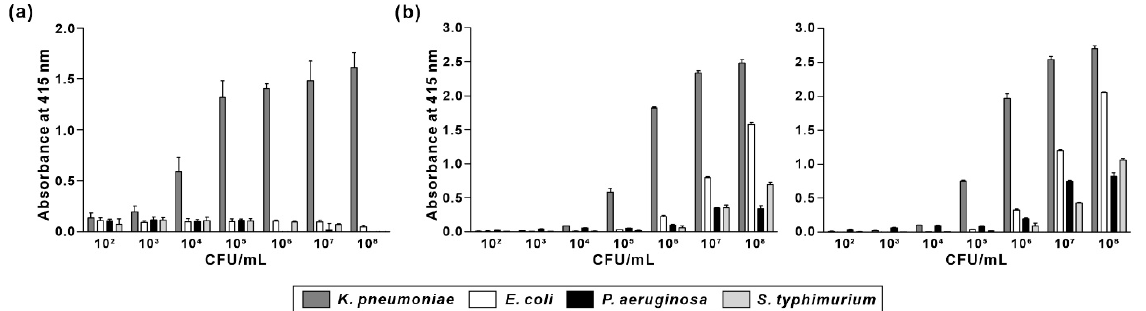
Figure 7. Comparison of specificity and sensitivity of KP peptide with commercially available anti- Klebsiella spp. antibodies. Microtiter plates were coated with different concentrations of bacterial cells (10 2 –10 8 CFU/mL) and incubated with biotinylated KP peptide ( a ) or anti- Klebsiella spp. antibodies [( b ) left: ab69468; right: GTX36396] prior to incubation with streptavidin-HRP. The substrate ABTS was used to detect the positive binding of the peptide or antibodies to bacteria. The data are presented as the mean ± SD of three independent experiments performed in triplicate.